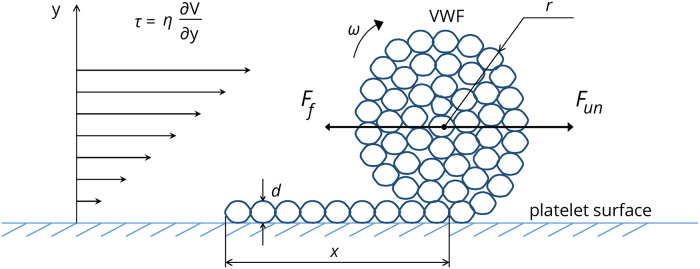
Partially unfolded VWF molecule in shear flow.r denotes the radius of the VWF globular part, x corresponds to the length of the unfolded part on the platelet surface (“tail”) of the molecule, d denotes the characteristic size of the VWF monomeric subunit, Ff denotes the force due to effective surface tension that tends to fold a VWF molecule, Fun is the force that unfolds a VWF molecule under the action of shear stress τ, η denotes blood viscosity, and ω reflects the rotational speed of the globular part of the molecule. The symbol dV/dy denotes a velocity gradient perpendicular to the direction of the flow (i.e. shear rate). Adapted from [35].